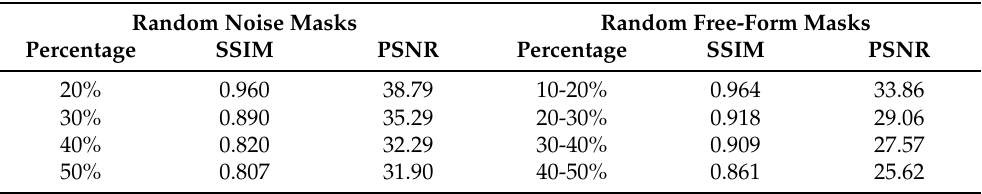
Table 2. Qualitative analysis of inpainting results of random noise and random free-form brush masks with different